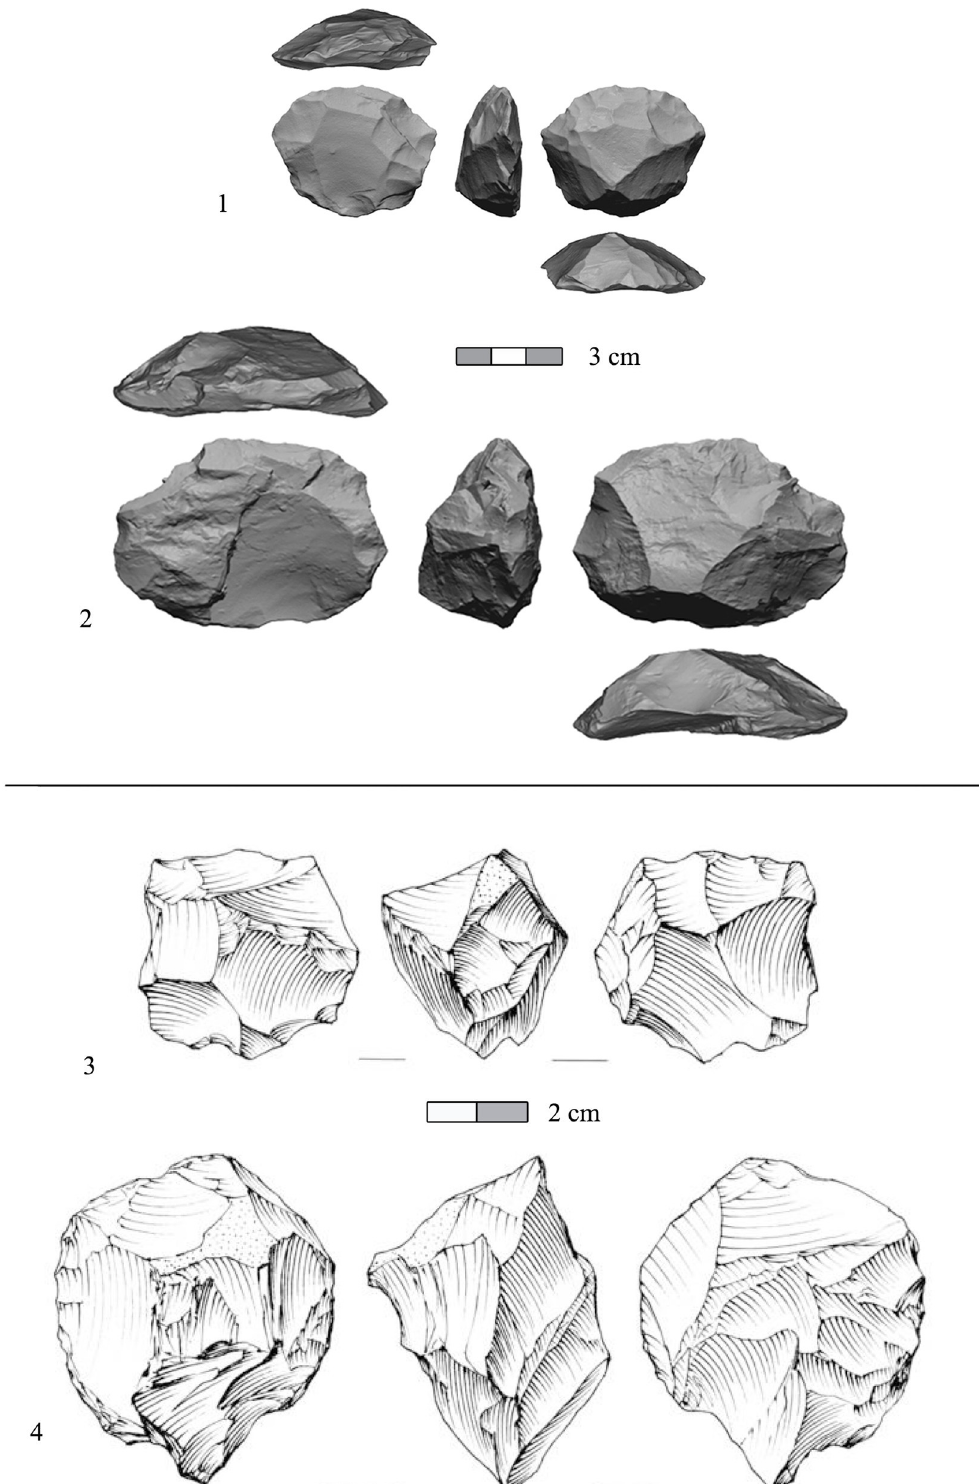
Fig 9. Prepared cores from the assemblage of Area B in Jaljulia. 1–2) Proto Levallois; 3) Discoid; 4) Prepared core (general).